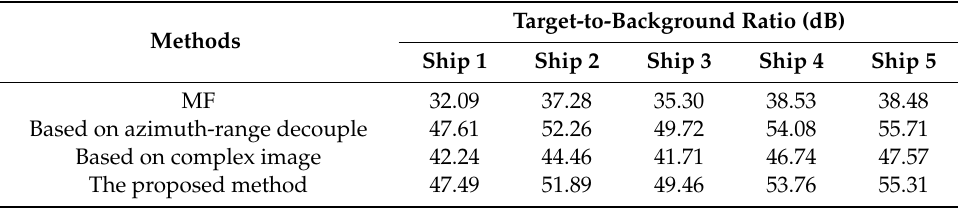
Table4. TBRoftargetregionsbasedondi ff erentmethodswithdownsampleddata(80%downsampling).